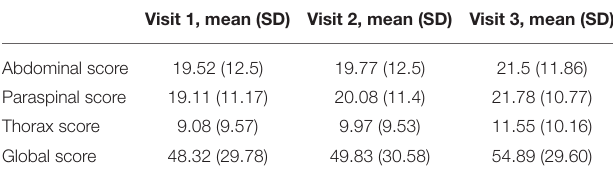
SD, standard deviation.